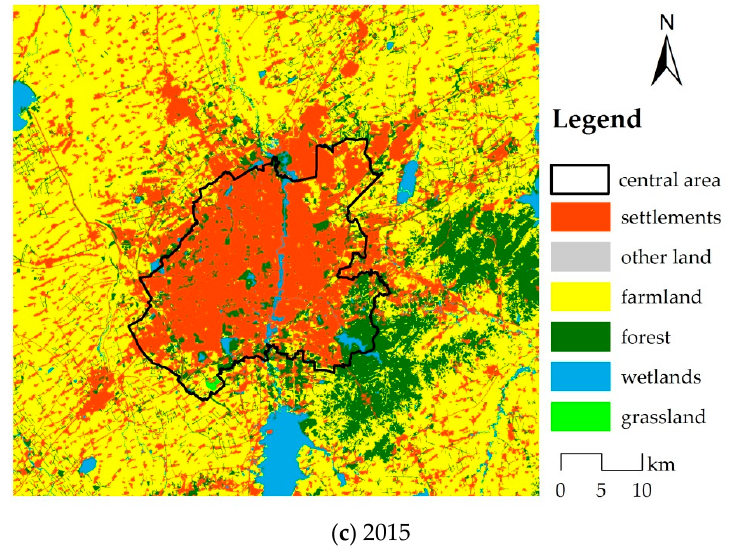
Figure 4. ( a – c ) Land use in Changchun (1995–2015).